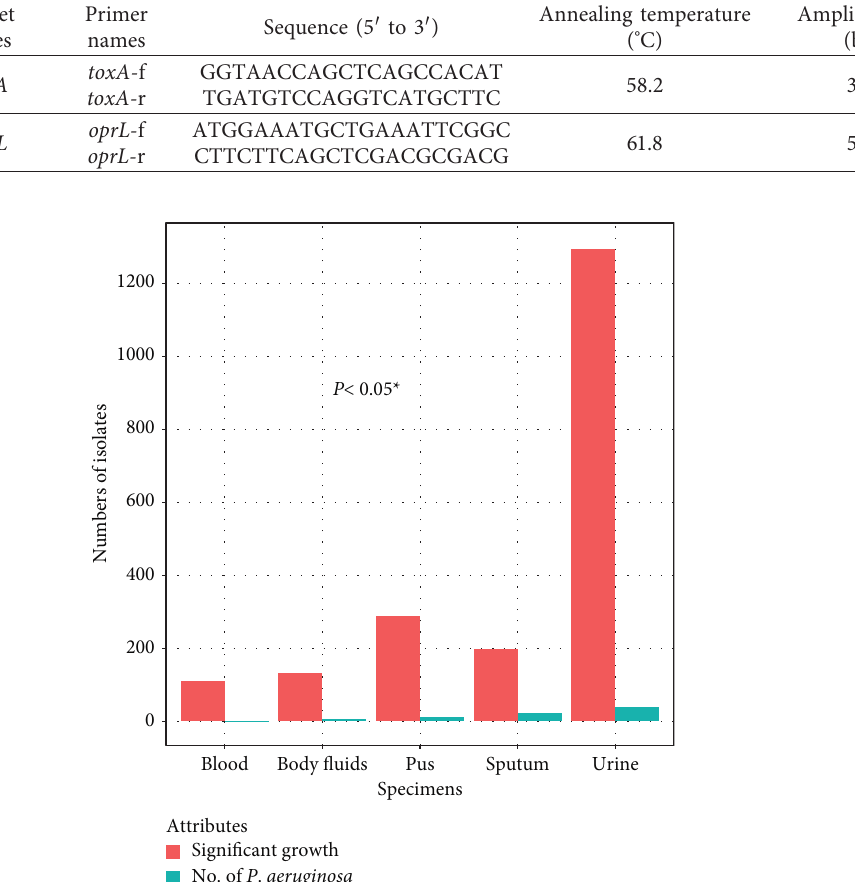
Figure 1: Distribution of P . aeruginosa among different clinical specimens. The isolation of P. aeruginosa and their significant growth from different specimens are significantly associated ( P < 0 . 05 ∗ ). Table 2: Clinical and sociodemographic characteristics of patients and distribution of MDR P. aeruginosa .